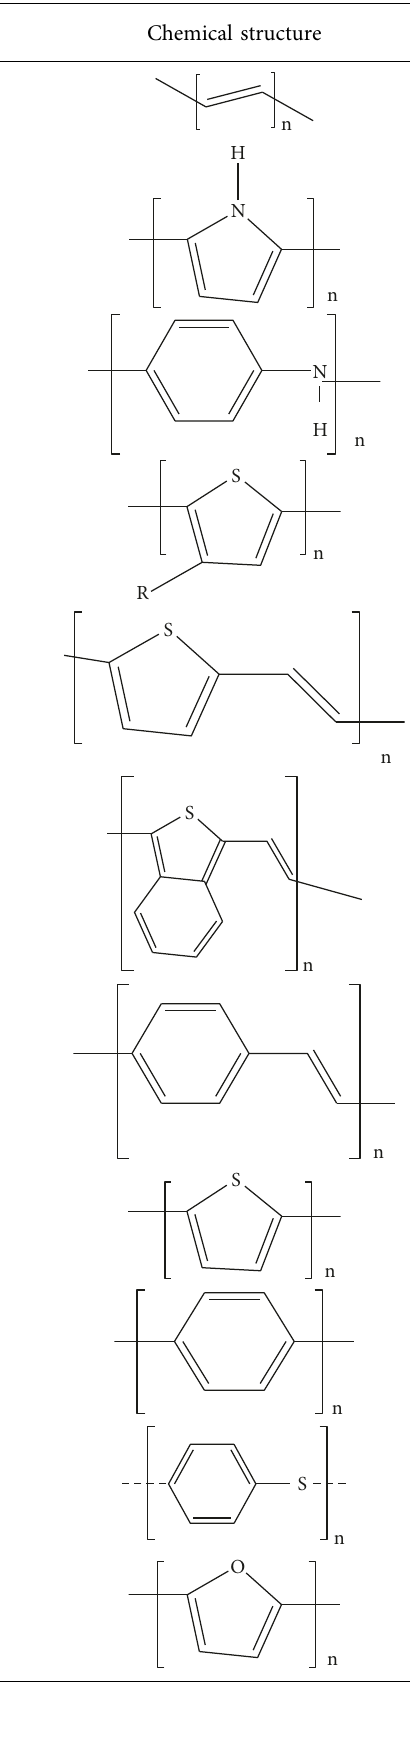
Table 1: List of some important conducting